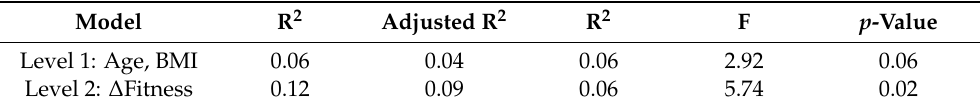
Table 11. Week 7 Fitness Hierarchal Regression.